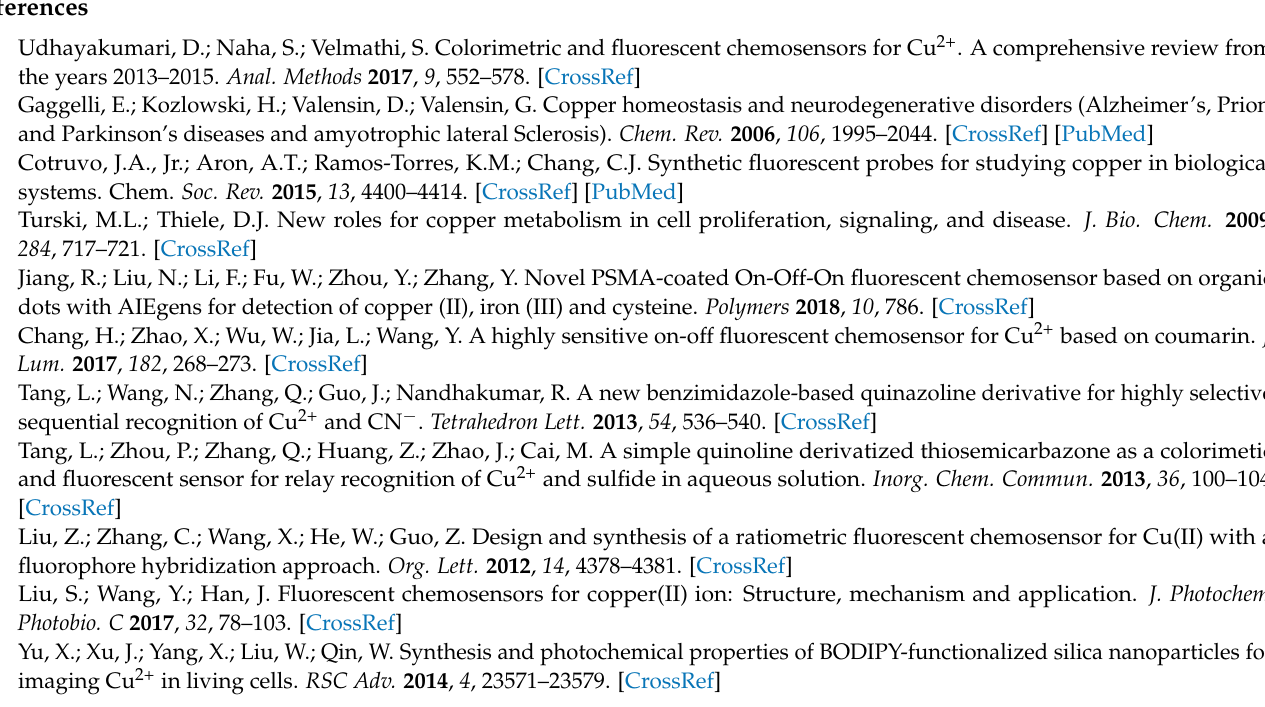
Figure S4: Mass spectrum of RB-OH, Figure S5: IR spectrum of P(MMA-co-RB), Figure S6: 1 H-NMR spectrum (400 MHz, CDCl3) of P(MMA-co-RB), Figure S7: GPC chromatograms of